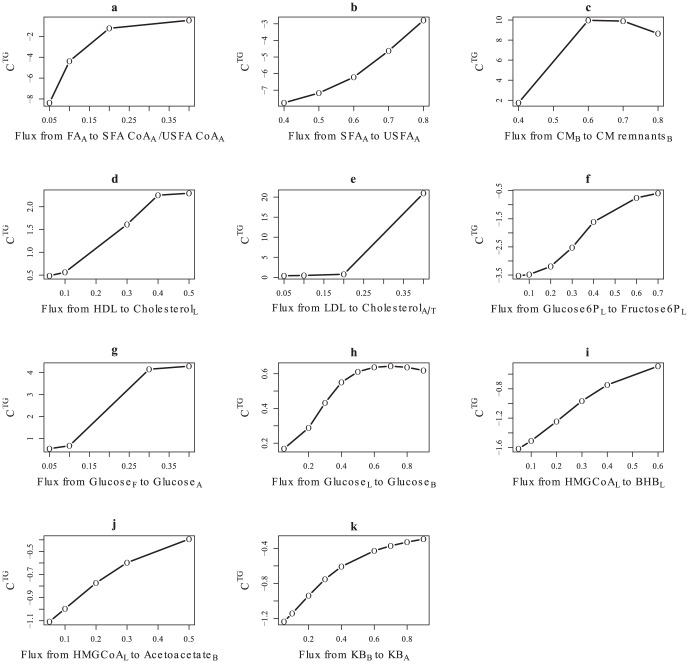

 of branch-points in SteatoNet.Range of  of a) activation of saturated (SFA) and unsaturated (USFA) fatty acids in adipose, b) desaturation of SFA to USFA in adipose, c) breakdown of chylomicron into chylomicron remnants, d) reverse cholesterol transport, e) LDL distribution to adipose and peripheral tissues, f) fructose-6-phosphate synthesis from glucose-6-phosphate, g) glucose transport to adipose, h) hepatic release of glucose into blood, i) β-hydroxybutyrate (BHB) synthesis from 3-hydroxy 3-methylglutaryl coenzyme A (HMG CoA), j) acetoacetate transport to blood, and k) uptake of ketone bodies (KB) by adipose.